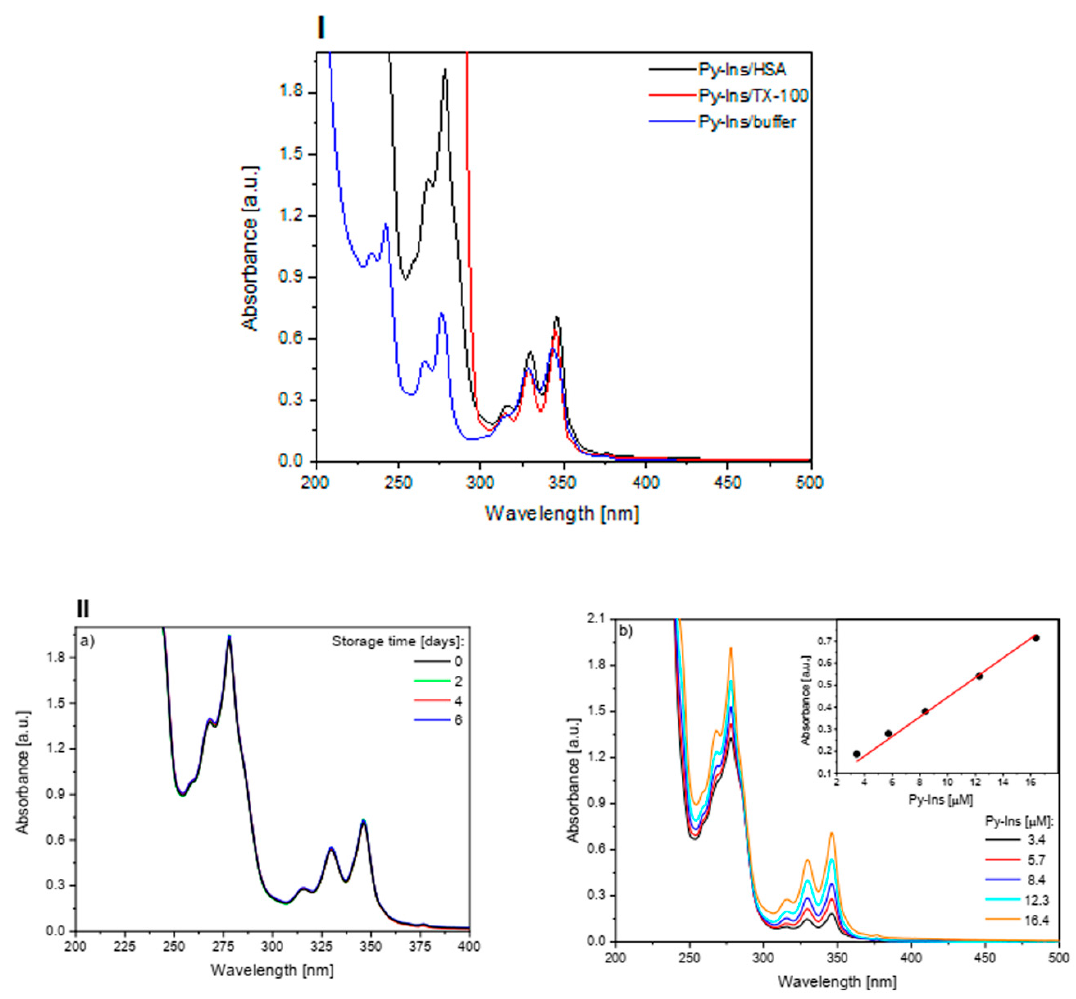
Figure 2. Panel I: Absorption spectra of Py-Ins ( 1 ) in PBS, and with additives: TX-100 or HSA. [Py-Ins] = 16.38 µ M, [TX-100] = 20 mM, [HSA] = 30 µ M. Panel IIa: Absorption spectra of HSA / Py-Ins ( 1 ) complex, [Py-Ins] = 16.38 µ M, [HSA] = 30 µ M recorded for the fresh solution and after 2, 4, and 6 days of storage. Panel IIb: Absorption spectra of HSA / Py-Ins (1), [HSA] = 30 µ M, [Py-Ins] as indicated (inset: dependence of A342 on the Py-Ins concentration).